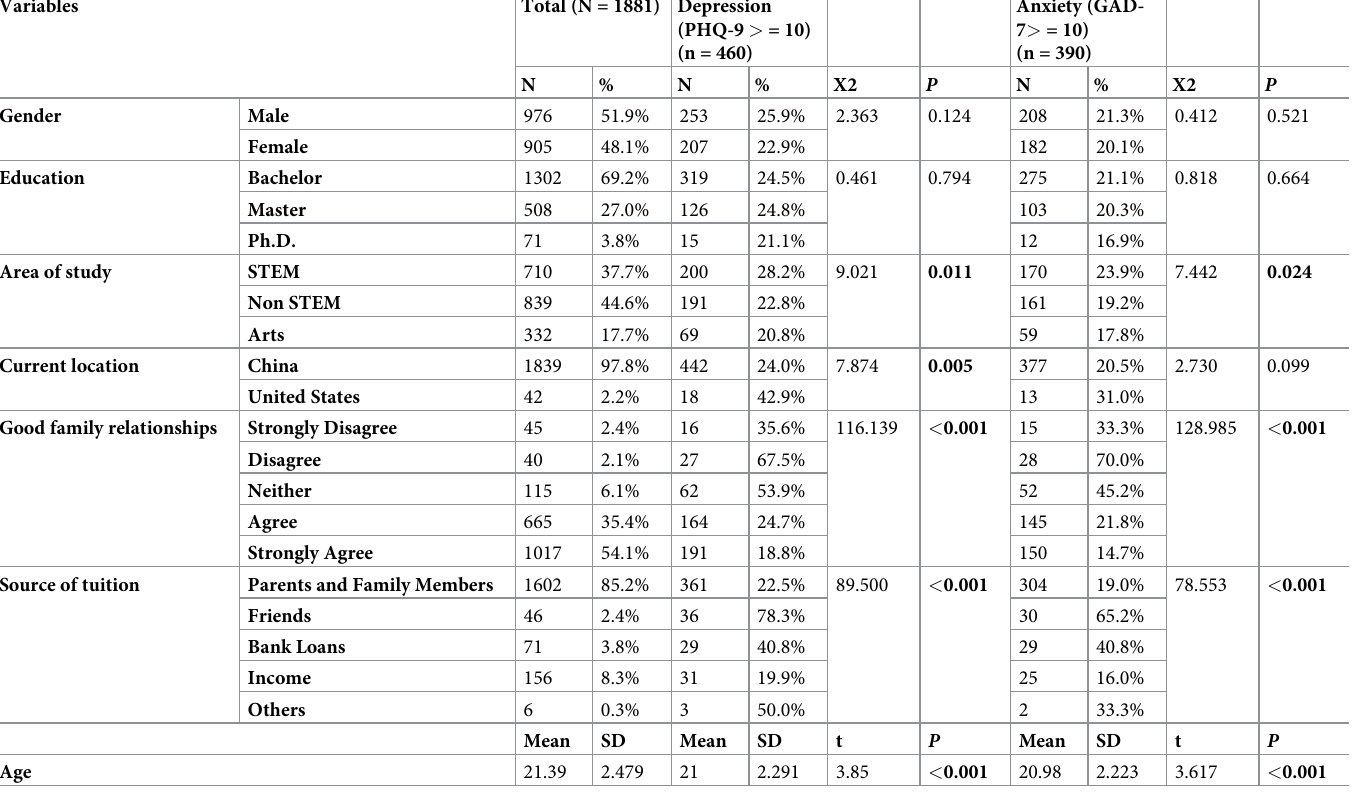
Table 1. Demographic characteristics of the sample cohort. Bivariant analyses were performed using two-tailed t-tests or χ 2 tests as appropriate.